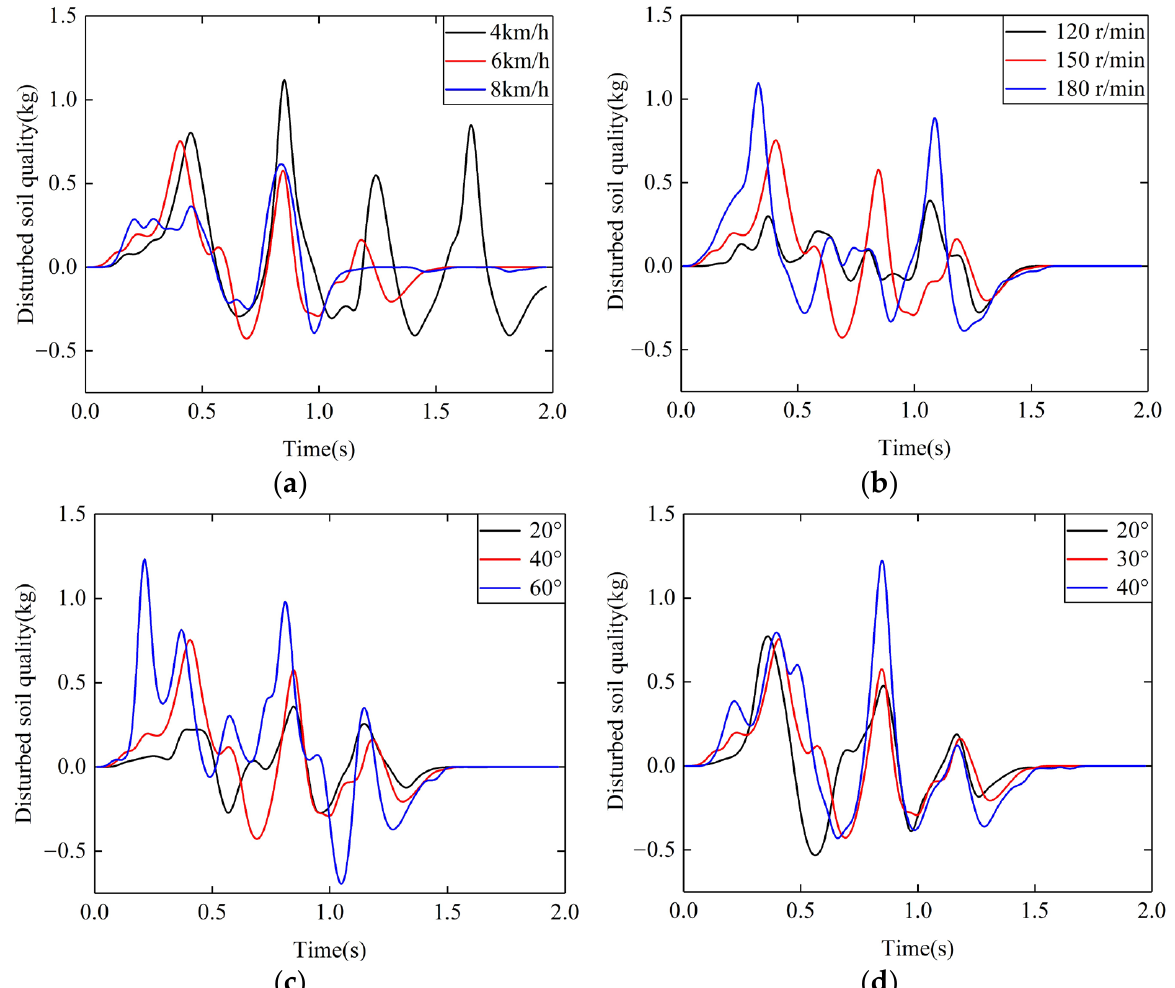
Figure 16. Variation curve of soil disturbance in seed furrow clearing under different parameters. ( a ) Forwarding speed; ( b ) Rotating speed; ( c ) Installation inclination angle of spring teeth; ( d ) Bend- ing angle of spring teeth.